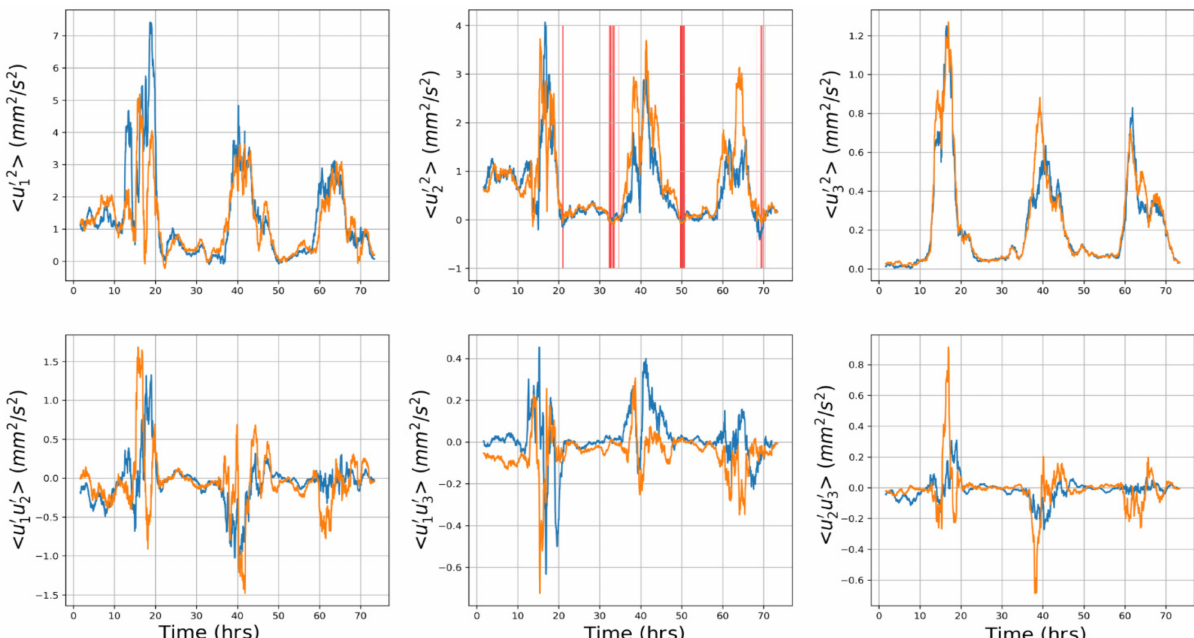
Figure 5. The dynamics of turbulent stresses calculated independently for each device. Top panel—pulsation intensities along axes X , Y , Z . Bottom panel—off-diagonal stresses. The time intervals, when realizability conditions were violated, are marked by the vertical red lines on the middle image of top panel.